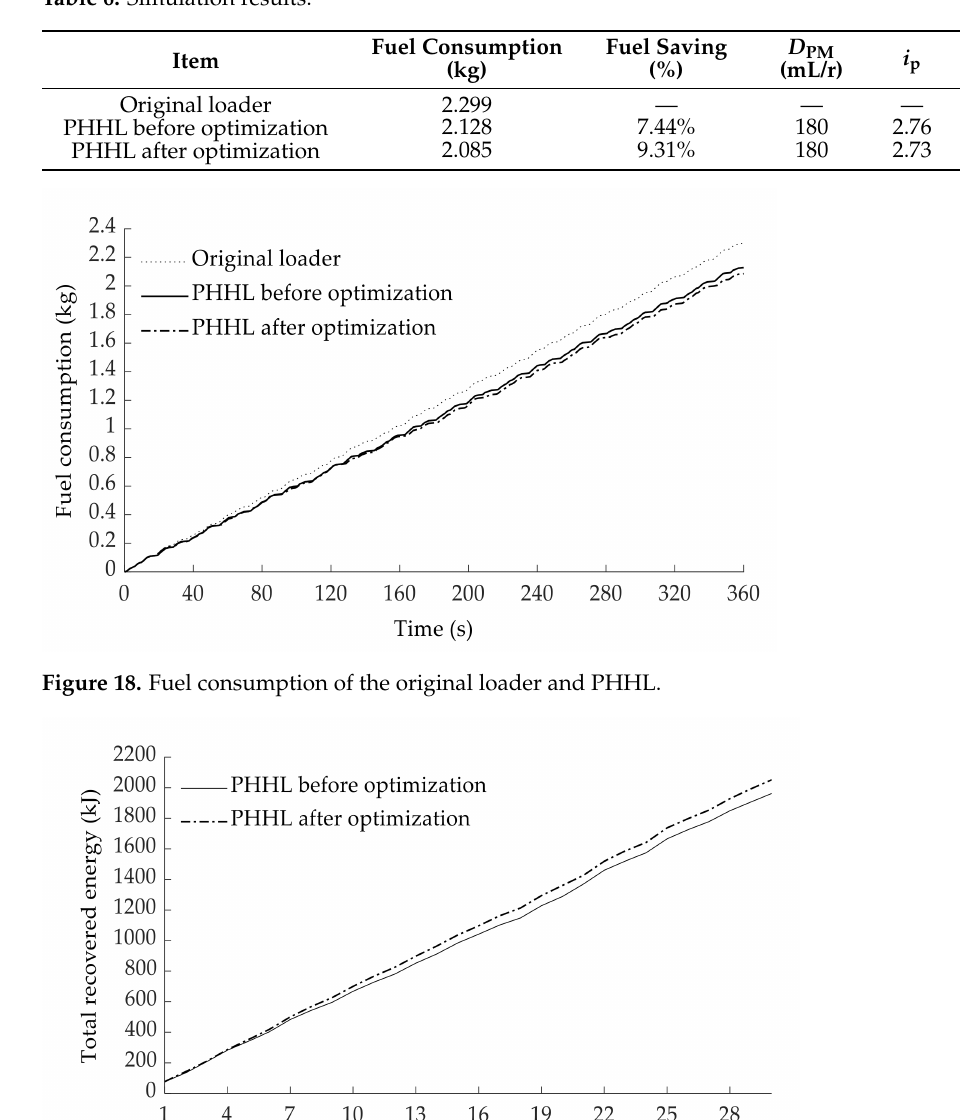
Table 6. Simulation results.